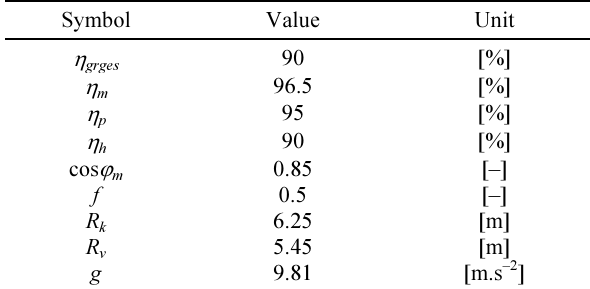
Table 6. Constant variables for SchRs 1320